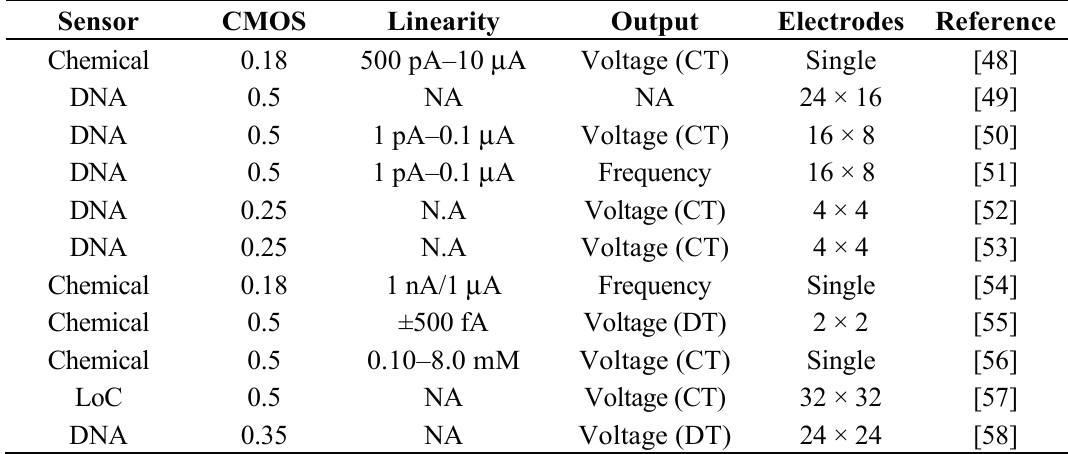
Table 1. CMOS based Voltammetry/Amperometry